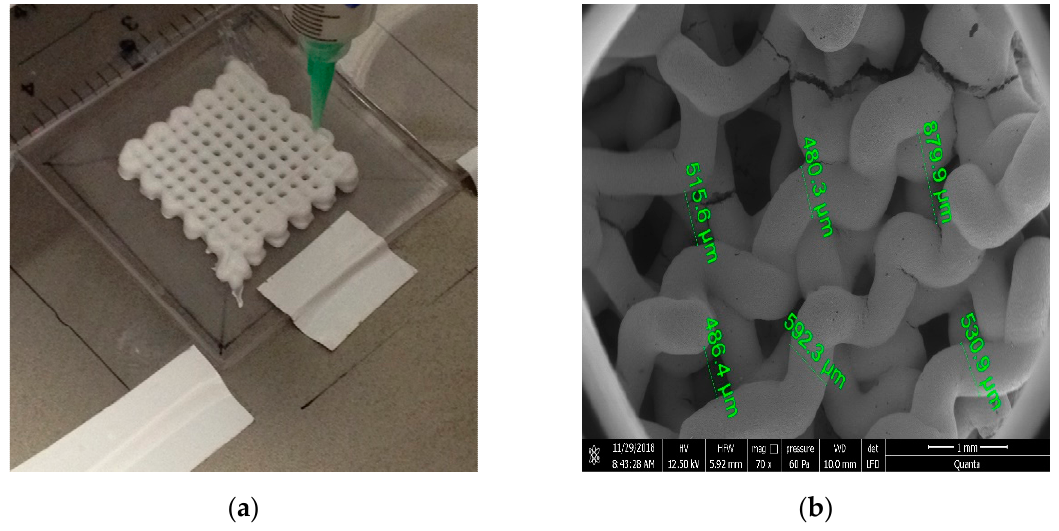
Figure 2. Hydroxyapatite scaffolds for bone tissue engineering made by 3D printing: ( a ) Macroscopic view; ( b ) Detailed view of the interconnecting channel structure with diameter of about 500 µm.